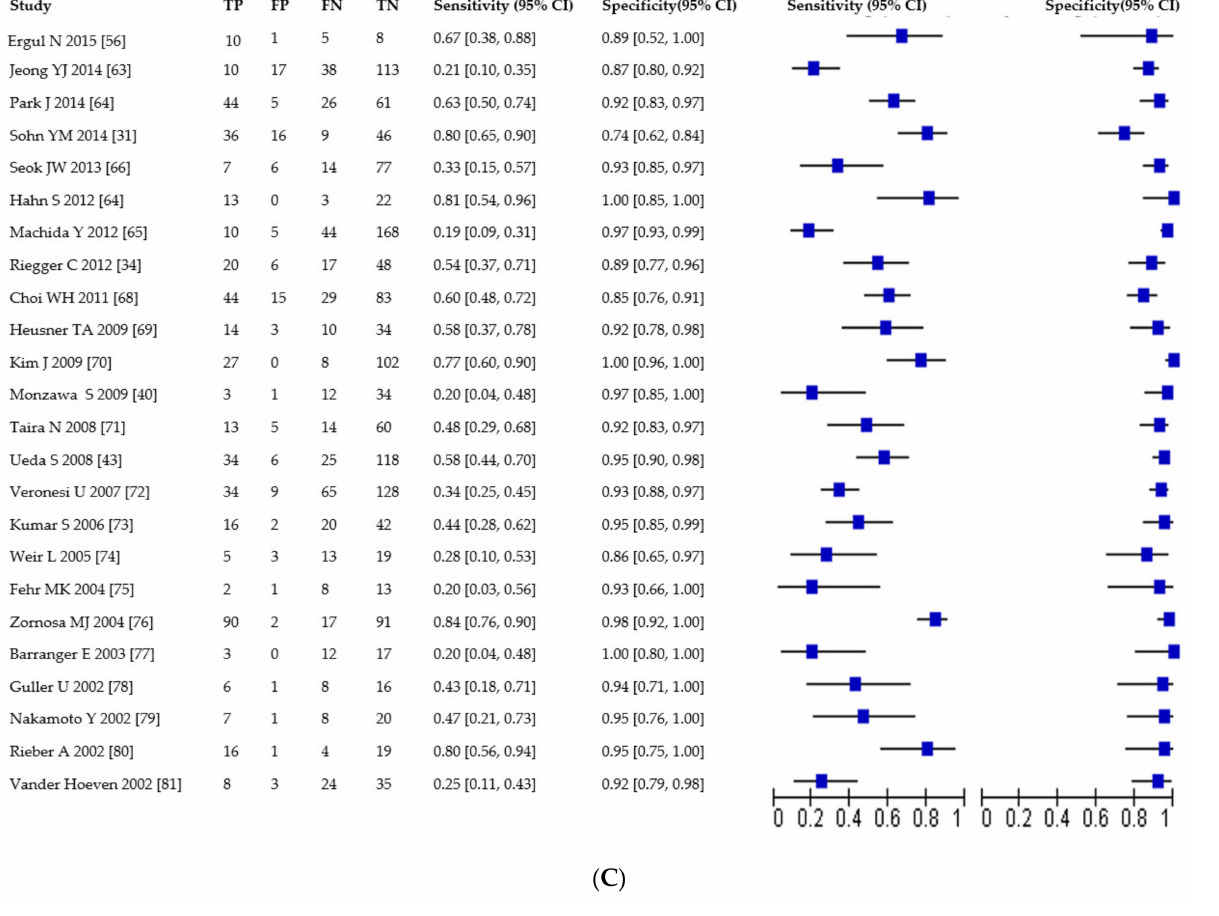
Figure 3. ( A ) Forest plot of sensitivity and specificity for US studies. TP = true positive, FP = false positive, FN = false negative, TN = true negative. Brackets show 95% confidence intervals. The figure shows the sensitivity and specificity for each study (squares) and 95% confidence intervals (horizontal lines). ( B ) Forest plot of sensitivity and specificity for MRI studies. TP = true positive, FP = false positive, FN = false negative, TN = true negative. Brackets show 95% confidence intervals. The figure shows the sensitivity and specificity for each study (squares) and 95% confidence intervals (horizontal lines). ( C ) Forest plot of sensitivity and specificity for PET studies. TP = true positive, FP = false positive, FN = false negative, TN = true negative. Brackets show 95% confidence intervals. The figure shows the sensitivity and specificity for each study (squares) and 95% confidence intervals (horizontal lines). Table 2. Summary estimates of sensitivity, specificity, diagnostic odds ratio, and their 95% confidence intervals of US, MRI, and FDG